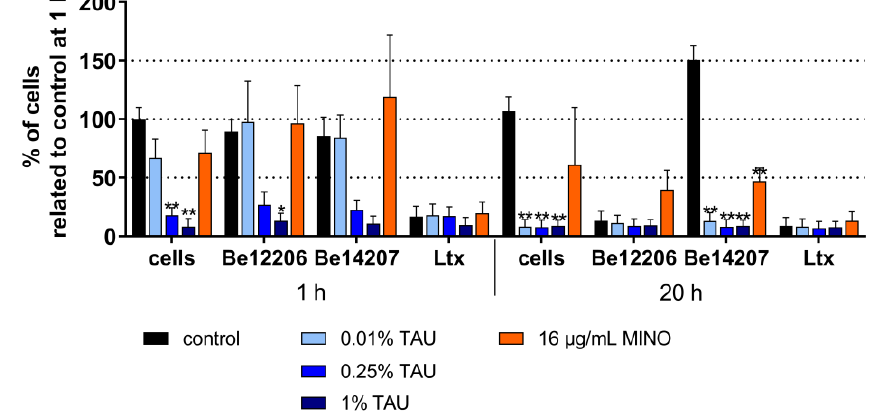
Figure 3. MTT activity (mean ± SD) of monocytic MONO-MAC-6 cells after infection with different Aggregatibacter actinomycetemcomitans strains (Be12206, Be14207), after addition of leukotoxin (ltx, 4 µg/mL) and exposure to 0.01%, 0.25%, and 1% taurolidine (TAU) as well as to 16 µg/mL minocycline (MINO).* p < 0.05, ** p < 0.01 vs. respective control.